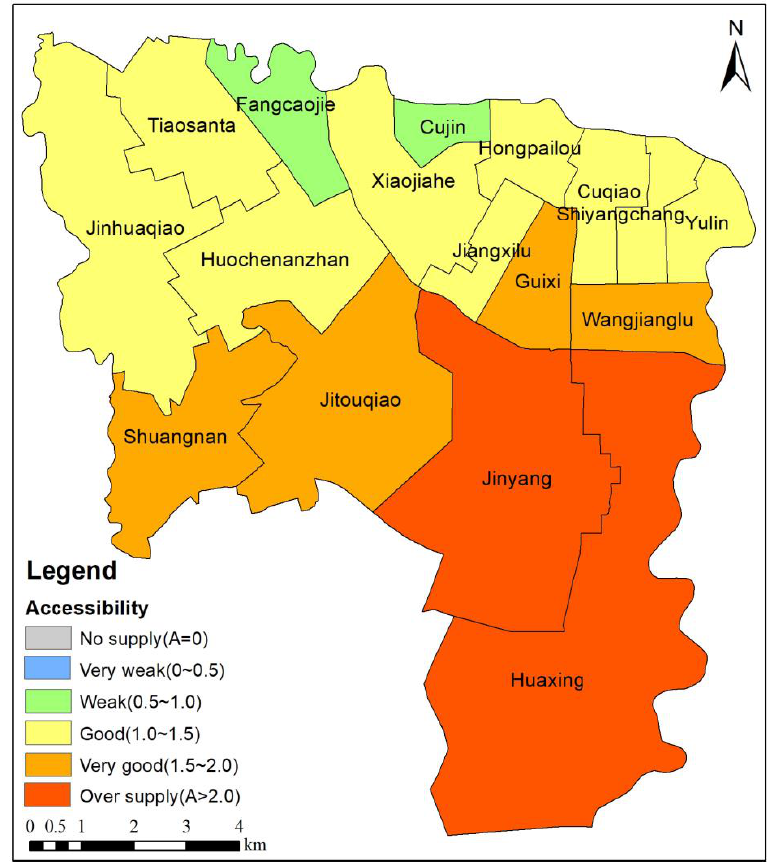
Figure 9. Park spatial accessibility in sub-district based on SCM-G2SFCA model.